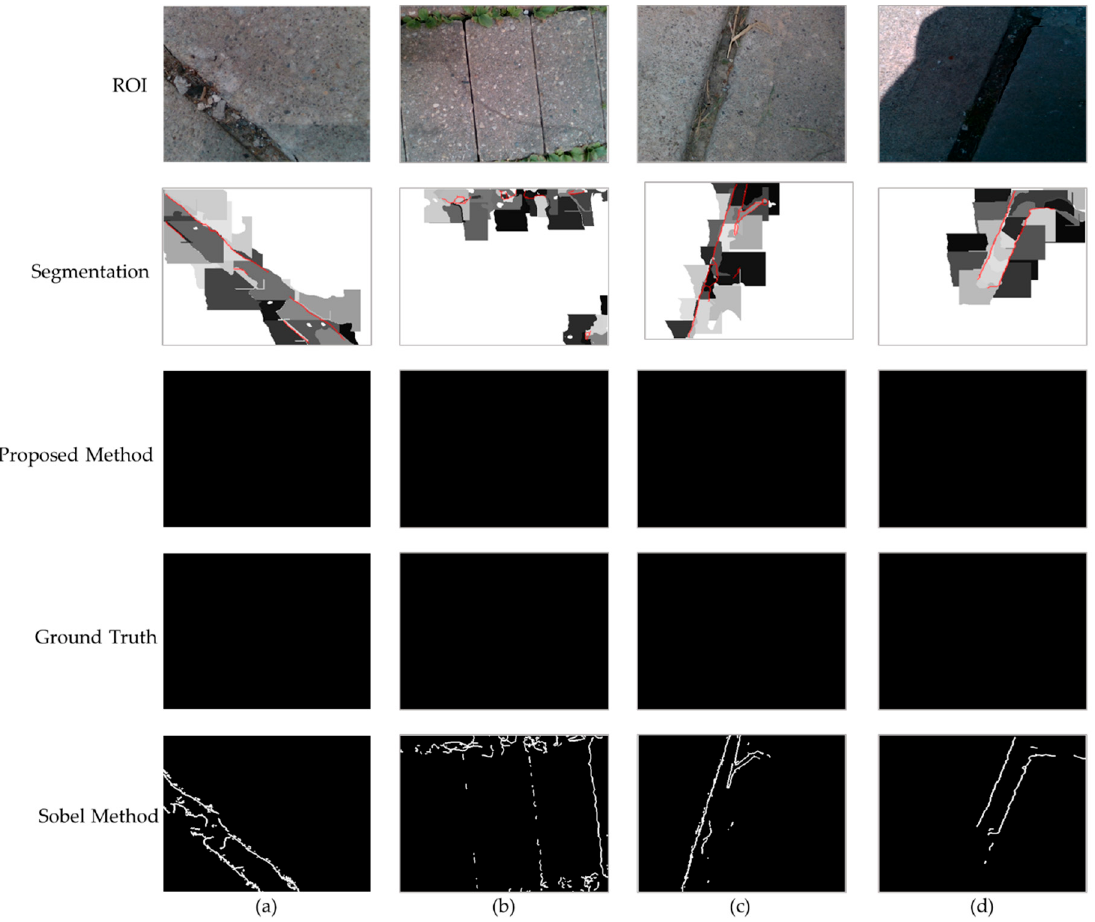
Figure 10. ( a – d ) are examples of our crack detection algorithm performed on slits, which are not considered tripping hazards where the first row shows the ROI images, the second row shows the images after segmentation with the crack outlined in red, the third row shows the final result of our edge detection algorithm, the fourth row shows the ground truth images, and the fifth row shows 5. Conclusions and Future Work.